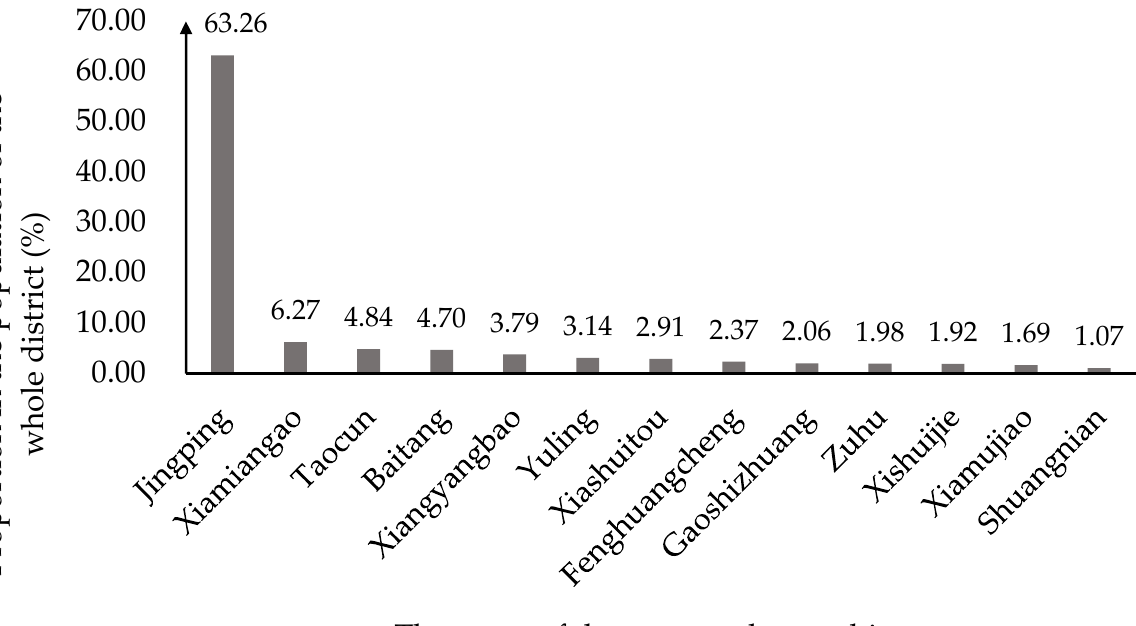
Figure 2. The population sizes of townships in Pinglu in 2020. (The data were compiled from the Shanxi Statistical Yearbook in 2020, and the figure was made by Shufei Wang.)